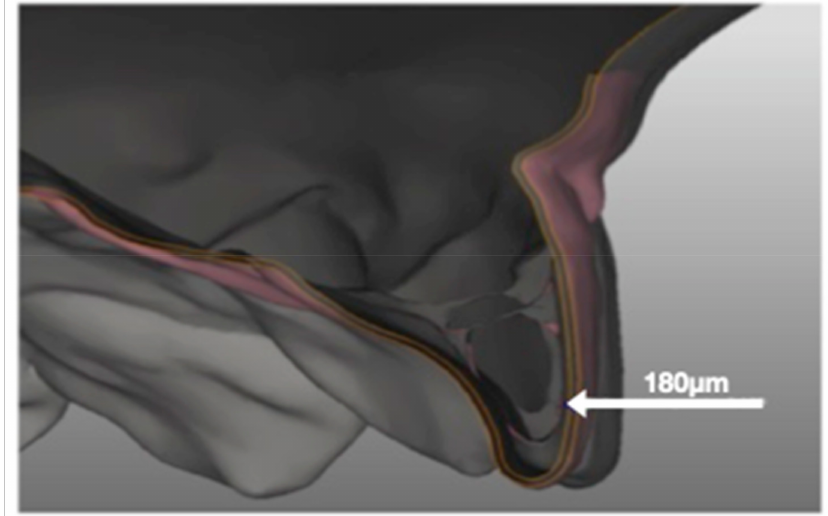
Figure 2. Sinergia software images generated with a view to creating the 180-micron pressure-film housing. The bright lines indicate exactly the thickness of 180 µ m that has been digitally eliminated from the 3D